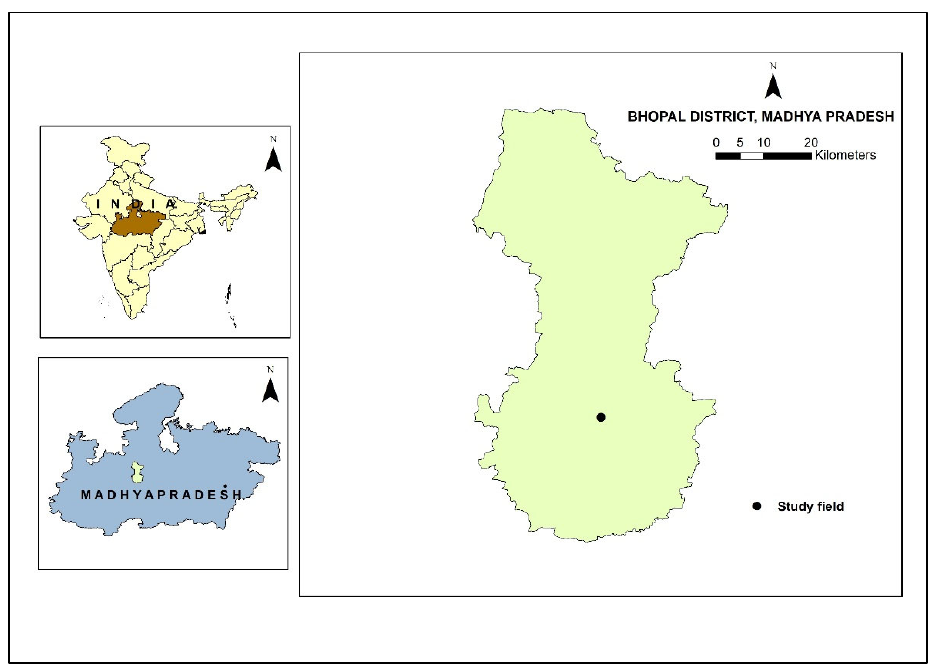
Figure 1. Location map of the study area. Table 1. Physical and chemical properties of initial experimental soil sample.